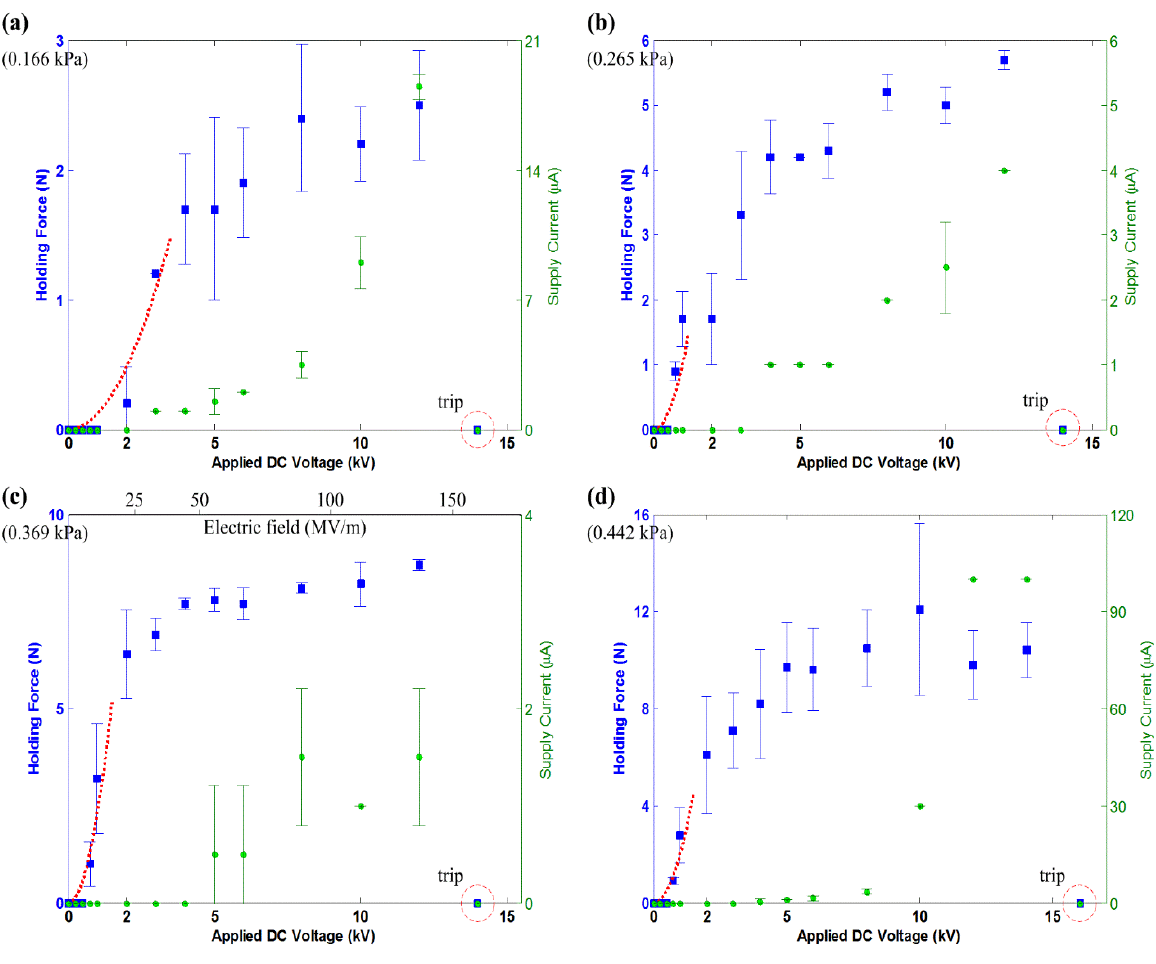
Figure 8. The measured holding force and supply current for electroadhesion actuators on the brick surface, shown with the tripped voltage level. The dashed line describes a quadratic fit over the data, which follows Equation (13). ( a ) B7×4, c = 0.12; ( b ) B7×5, c = 1.0; ( c ) B7×6, c = 2.3; ( d ) B7×8, c =